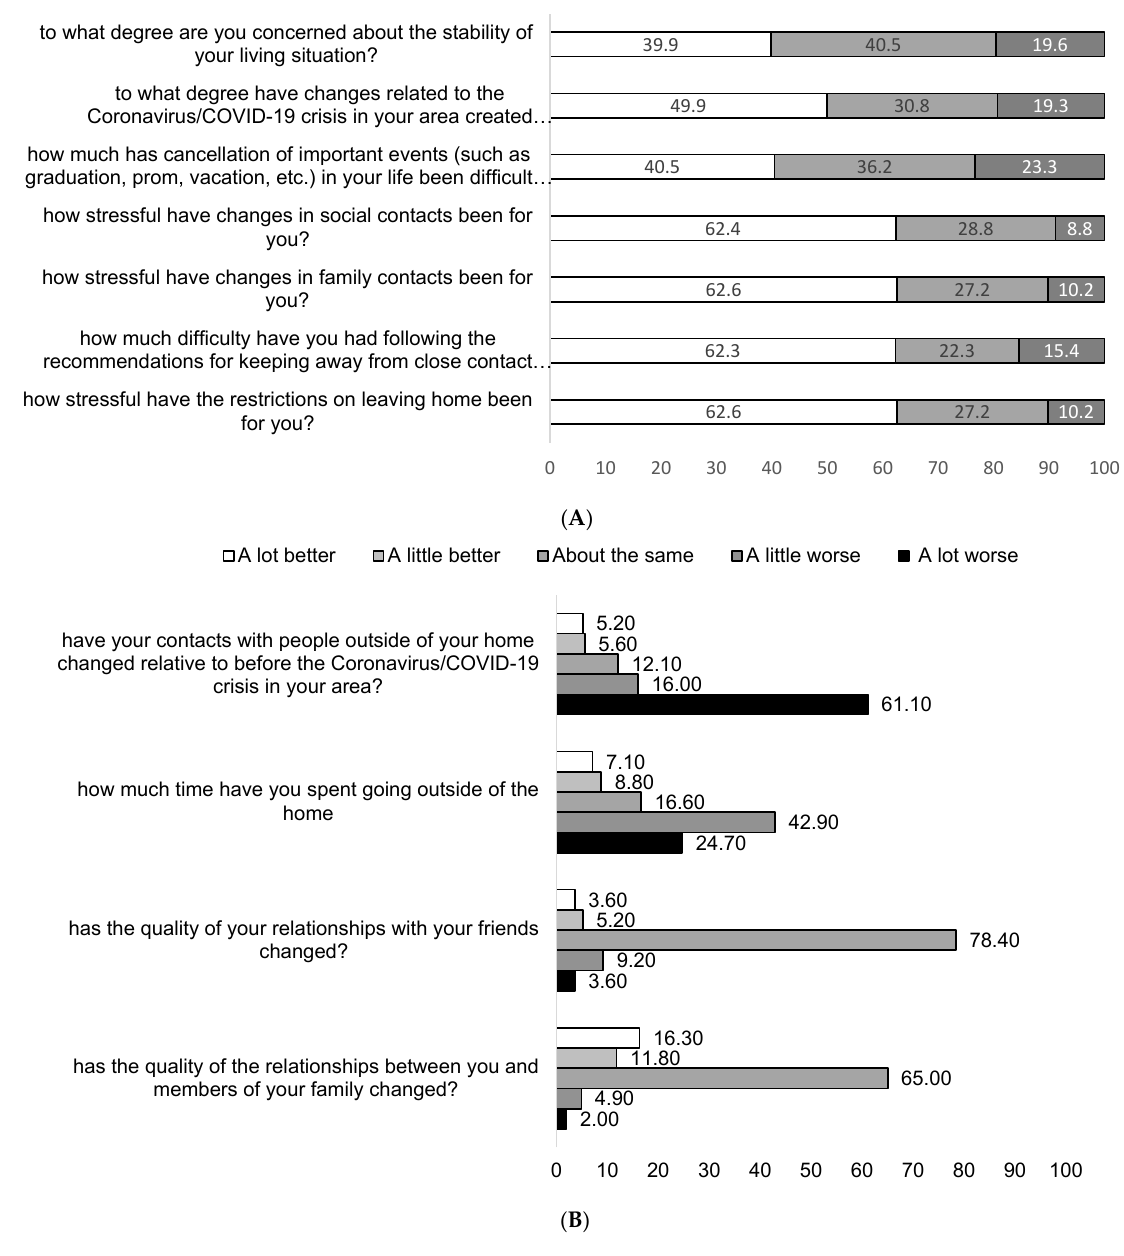
Women reported worrying moderately to extremely about family members or friends becoming infected with COVID ‐ 19 ( N = 215, 69.7%), whether it is safe, if infected, to be hospitalized ( N = 216, 70.3%), having to self ‐ quarantine/be isolated from family members ( N = 217, 71.0%), and having to be isolated from the baby ( N = 238, 77.6%). Women reported worrying less about becoming themselves infected by COVID ‐ 19 (60% reported moderate to extreme worry) and having to give birth by C ‐ section (50.2% re ‐ ported moderate to extreme worry; Table 3). Table 3. Worries related to COVID ‐ 19 and bivariate correlations between worries and PSS a for the total sample ( N = 308). Worries